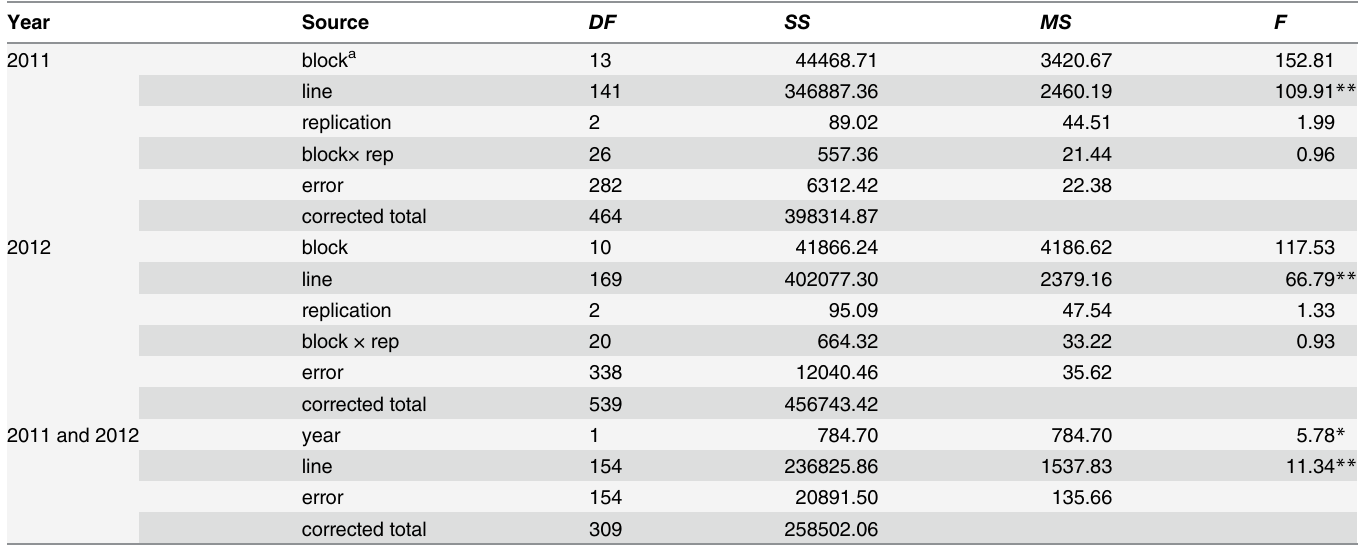
Table 2. Analysis of variance of HSR in the doubled haploid